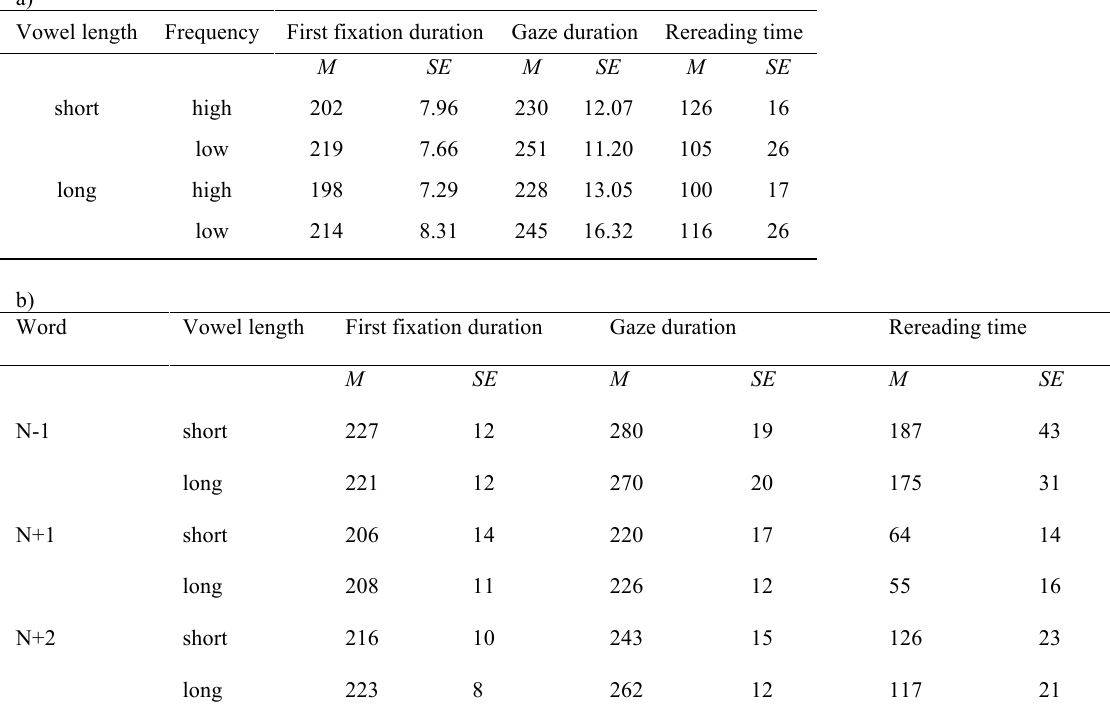
Mean first fixation durations, gaze durations, and rereading time in Experiment 3, a) on target words with short vs. long vowels and of high vs. low frequency, b) on surrounding words as a function of target word vowel